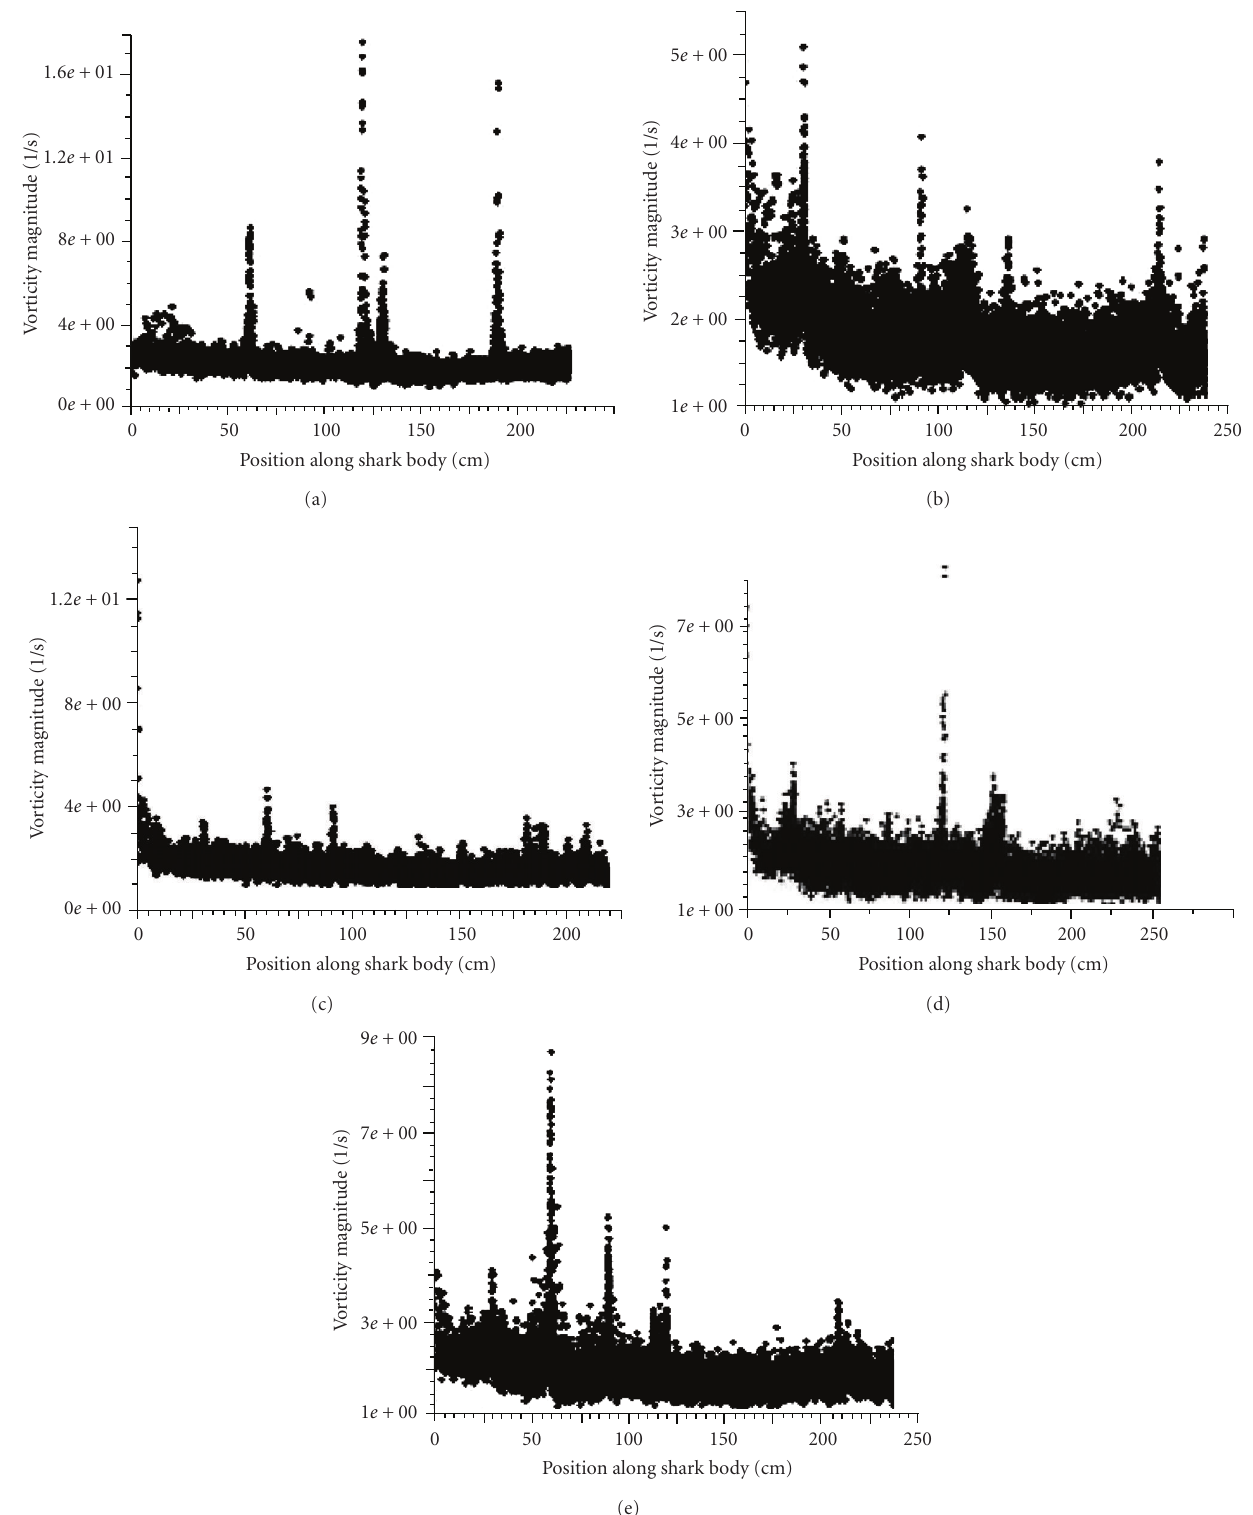
Figure 5: Vorticity magnitudes (1/s) of shark (a)–(e) body models. The x -axis on the figure represents the y -axis along the shark body models (nose to fork in the tail) and the y -axis shows the vorticity magnitude at every position on the shark at that particular y value. In this way, the figure shows the maximum vorticity magnitude at each position along the shark body model, clearly illustrating spikes of vorticity at the position of the gill slit and